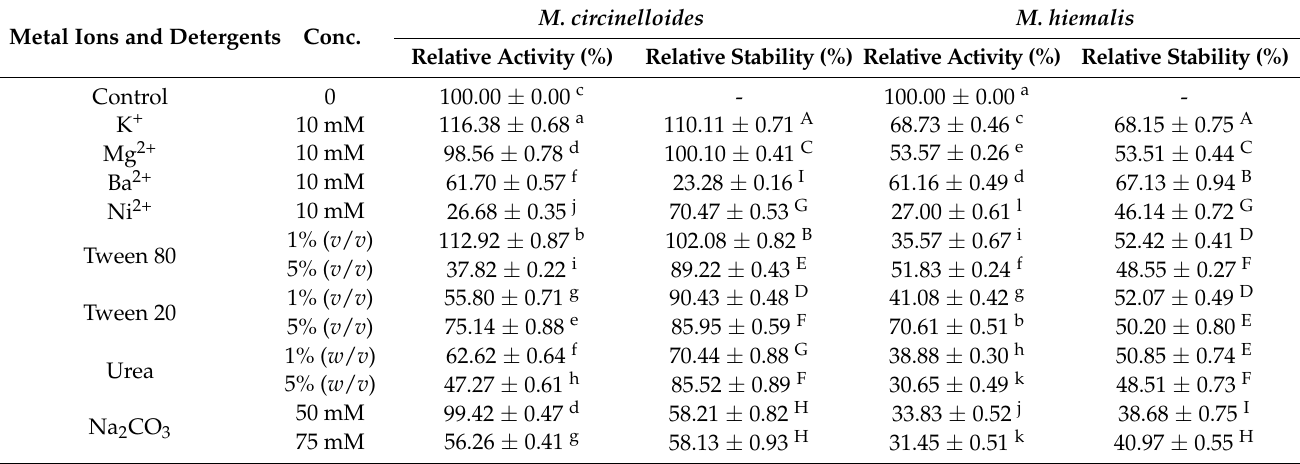
Table 11. Effects of metal ions and detergents on activity and stability of partially purified pectinase from M. circinelloides and M. hiemalis